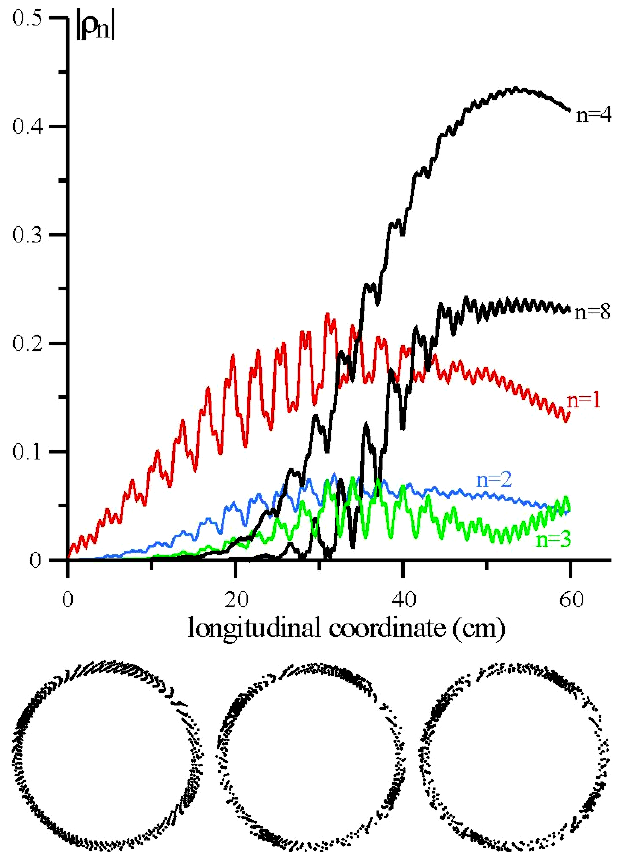
FIG. 7. (Color) Frequency quadrupling: operating (black curves) and spurious (color curves) harmonics of the electron current distribution of electrons versus the longitudinal coordinate (cid:3) n over their gyrophases and Larmor radii for the case of 10% velocity